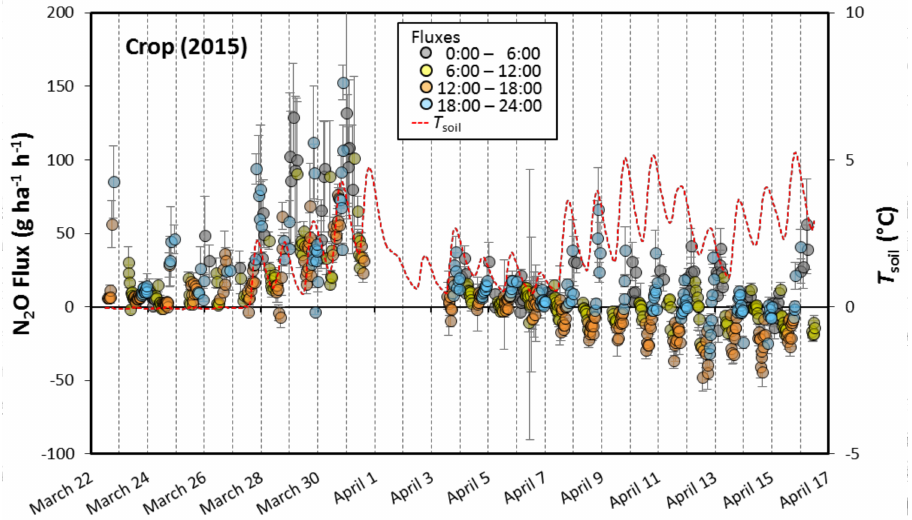
Figure 3. Time series of N 2 O fluxes from the Crop site (circles), and soil temperature at 5 cm depth ( T soil ) taken at a weather station near the site (red dashed line). Error bars correspond to a 1 − σ calculation of flux uncertainty. Symbol color indicates the time of day of the flux observation. Vertical gridlines show midnight at each